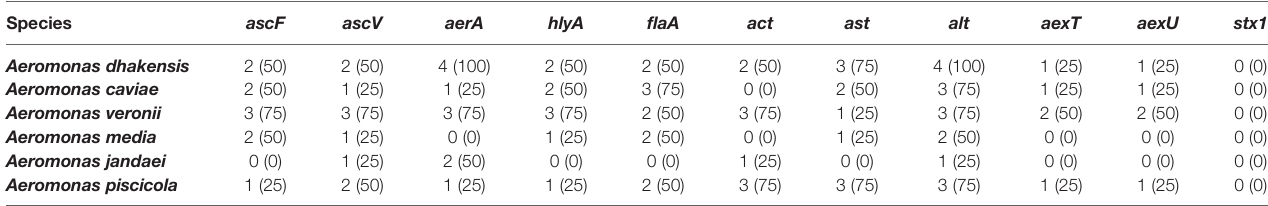
TABLE 3 | Distribution of virulence factors in Aeromonas strains.